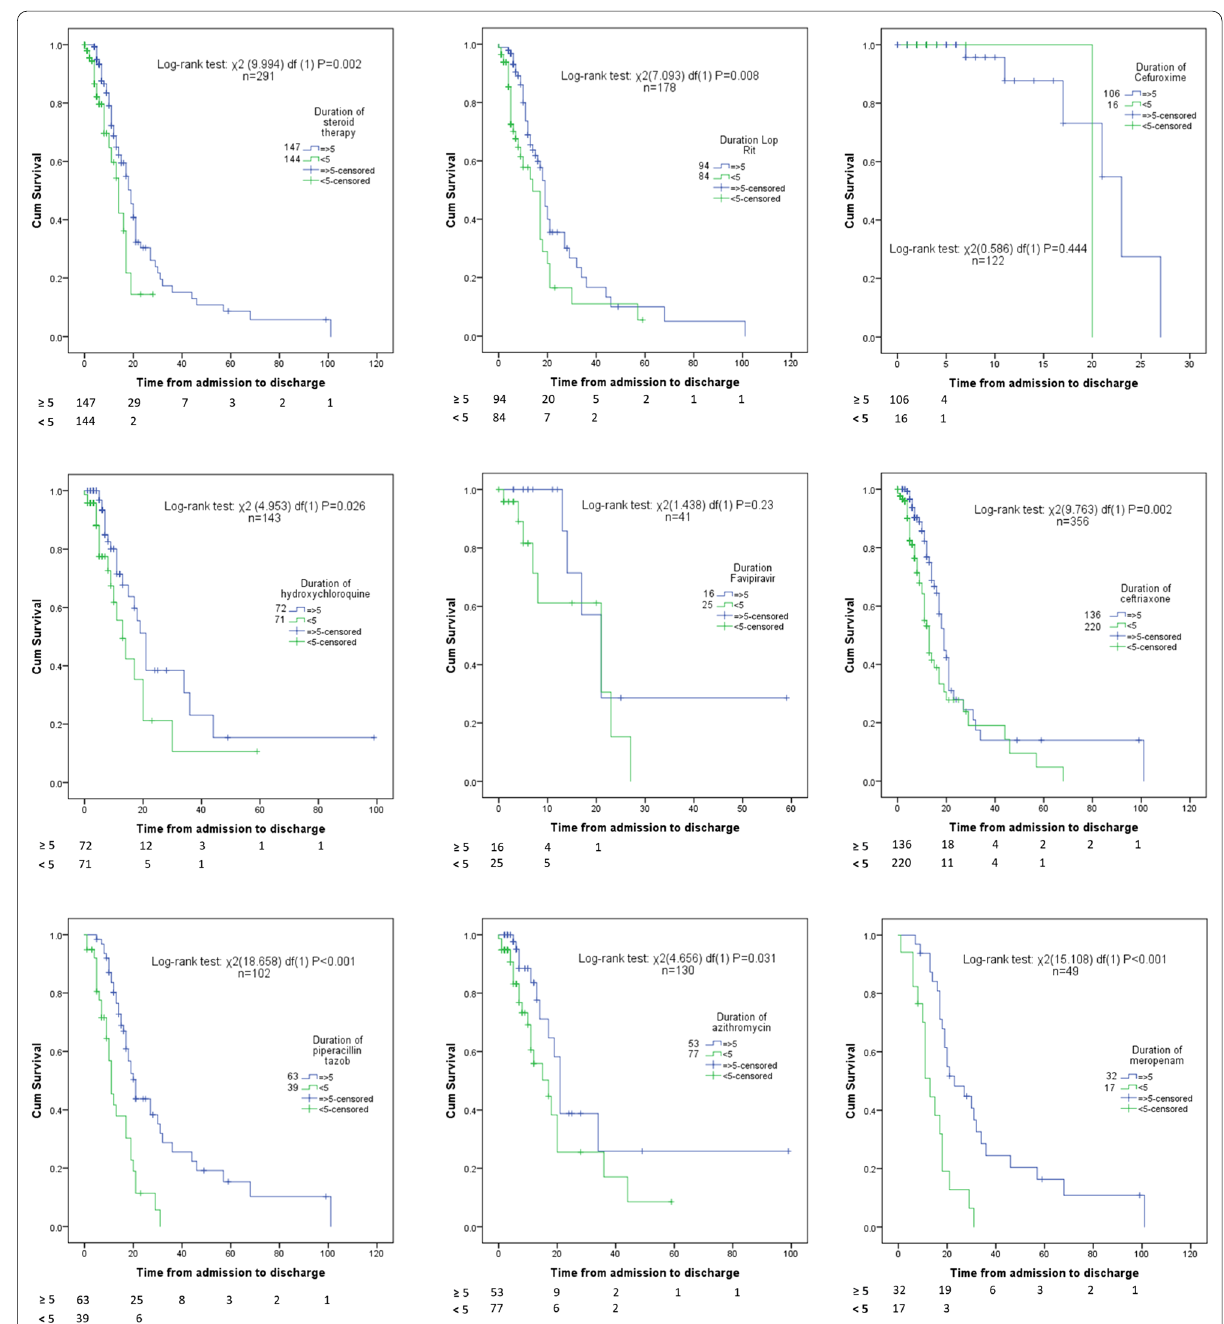
Fig. 1 Kaplan–Meier survival curves of certain medications for hospitalised COVID19